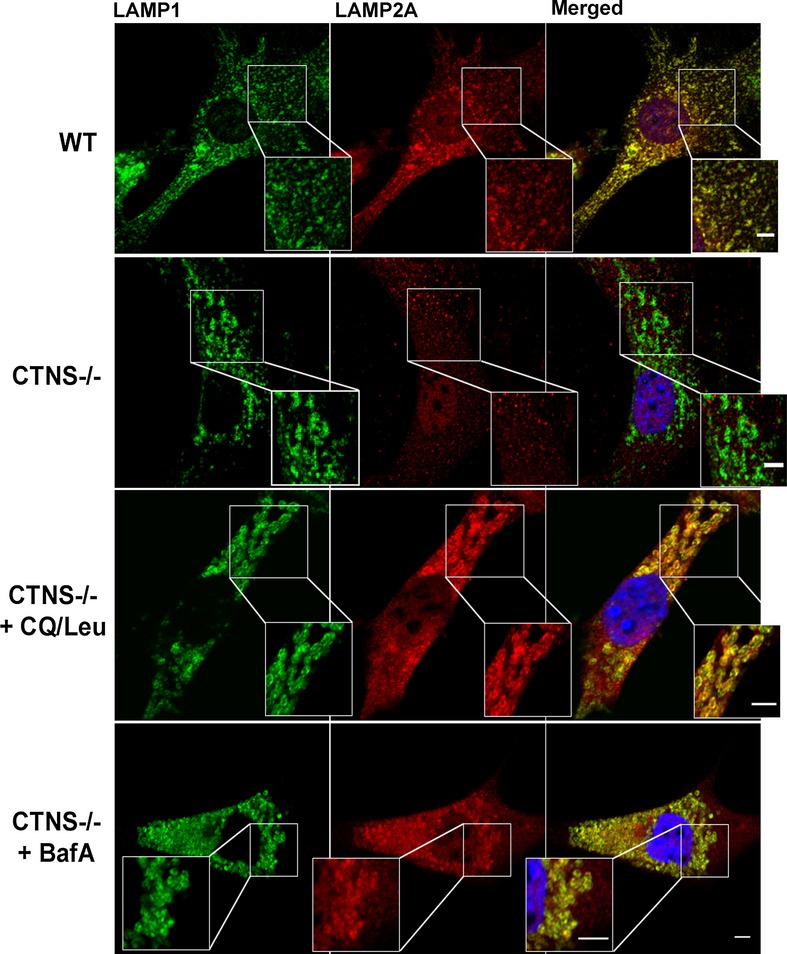
Lysosomal localization of LAMP2A in Ctns−/− cells is rescued by inhibition of lysosomal proteasesWT,Ctns−/− or Ctns−/− mouse fibroblasts treated for 20 h with either a combination of both leupeptin and chloroquine (CQ/Leu) or bafilomycin A (BafA) alone were fixed and immunostained with antibodies recognizing endogenous LAMP1 and LAMP2A proteins and samples were analyzed by confocal microscopy as described in Material and Methods. Lysosomal colocalization of LAMP1 and LAMP2A was evident in treated (middle lower and bottom panels) but not in untreated (middle upper panels) Ctns−/− cells. Scale bars: 5 μm. Inset scale bars: 2 μm.